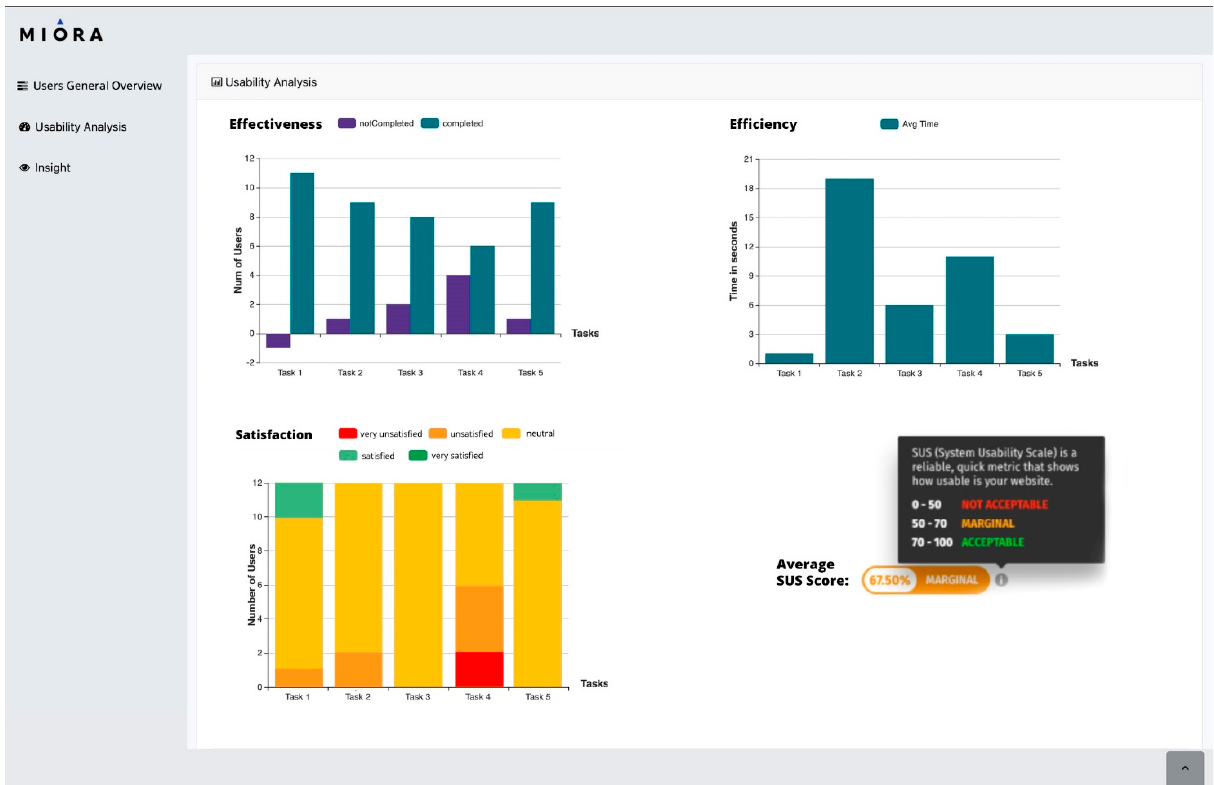
Figure 5. Usability Analysis section of the Miora tool.